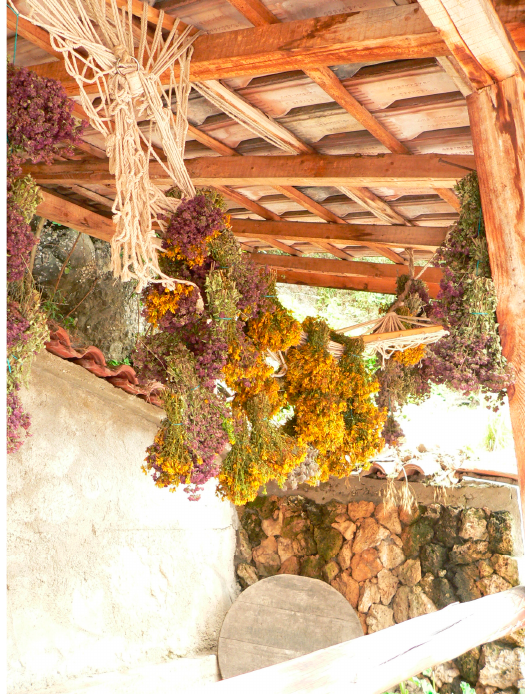
Figure 7. Collection of herbs in the Central Rhodopes— O. vulgare subsp. vulgare and Hypericum perforatum .